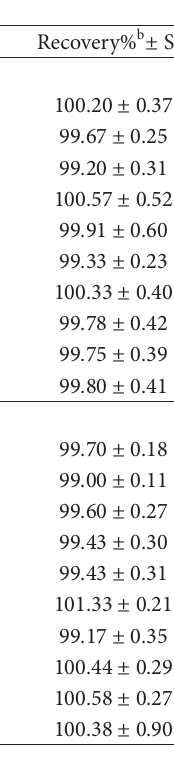
Table 7: Interday and intraday accuracy and precision for the determination of GMF and MOX in bulk powders by the proposed method (fixed